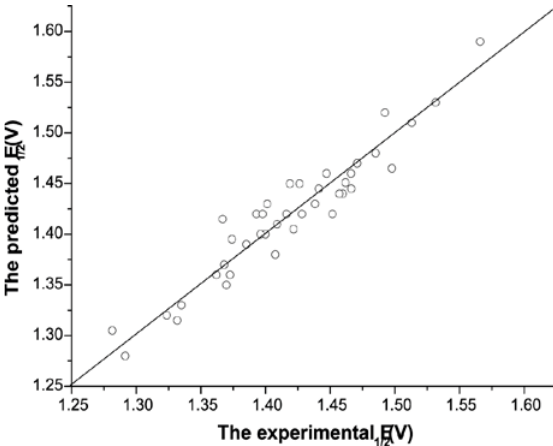
Figure 3. Experimental E